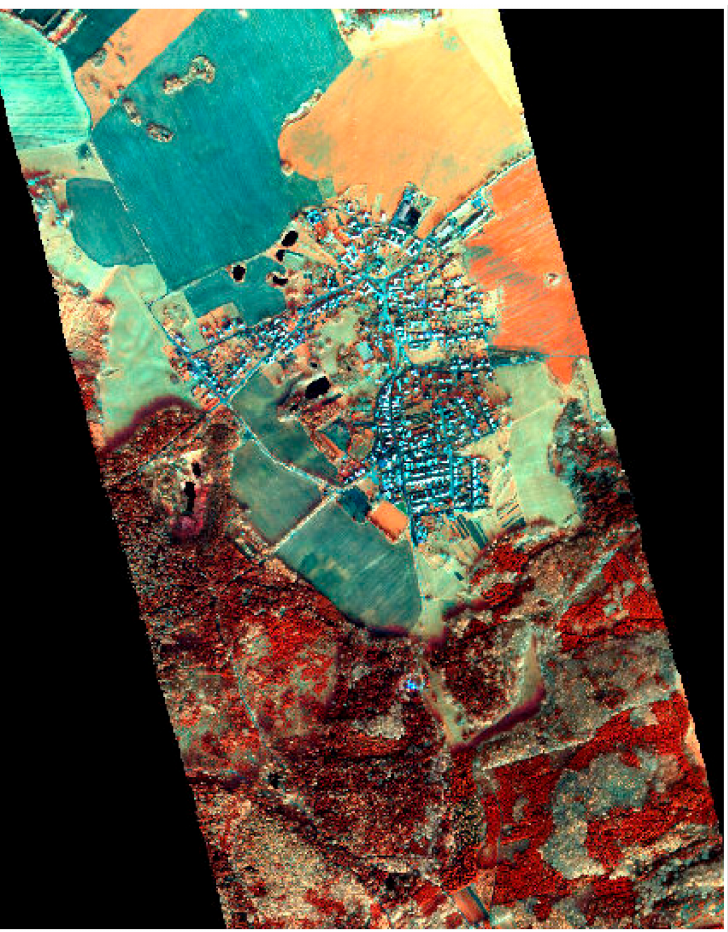
Figure 4. False color FLIS hyperspectral image (band 9 as red, band 40 as green, and band 67 as